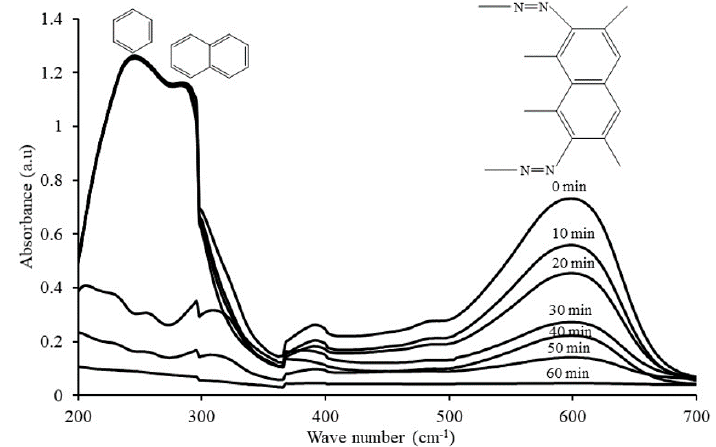
Figure 15. UV–visible absorption spectrums of RB5 azo dye at different time intervals.